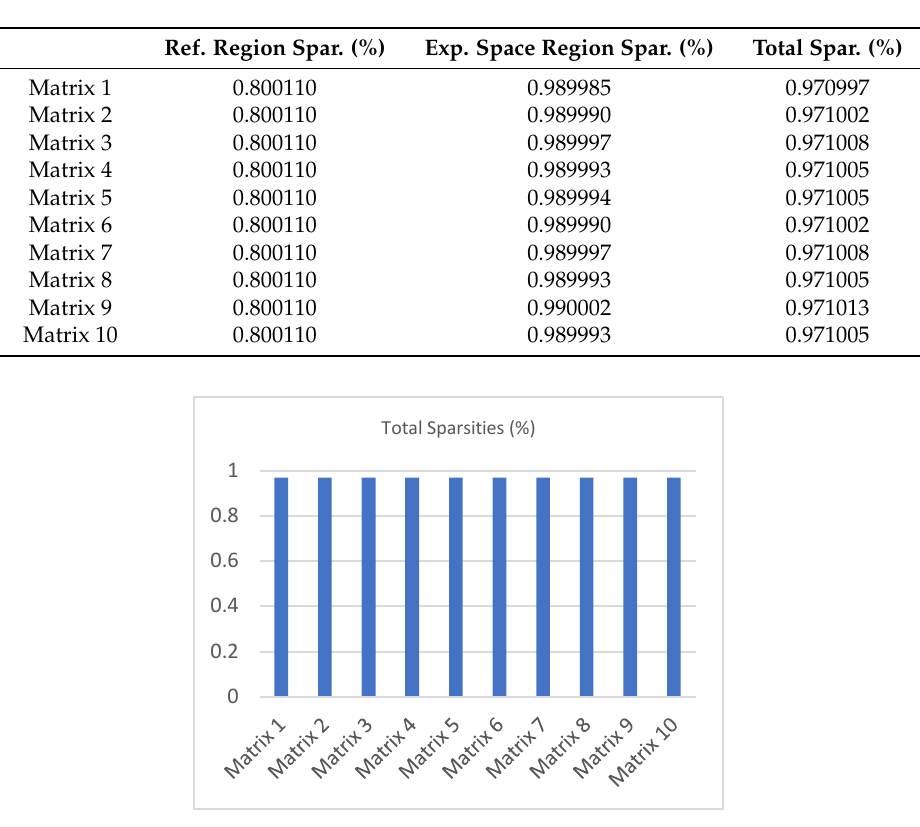
Table 4. Matrices sparsity information.